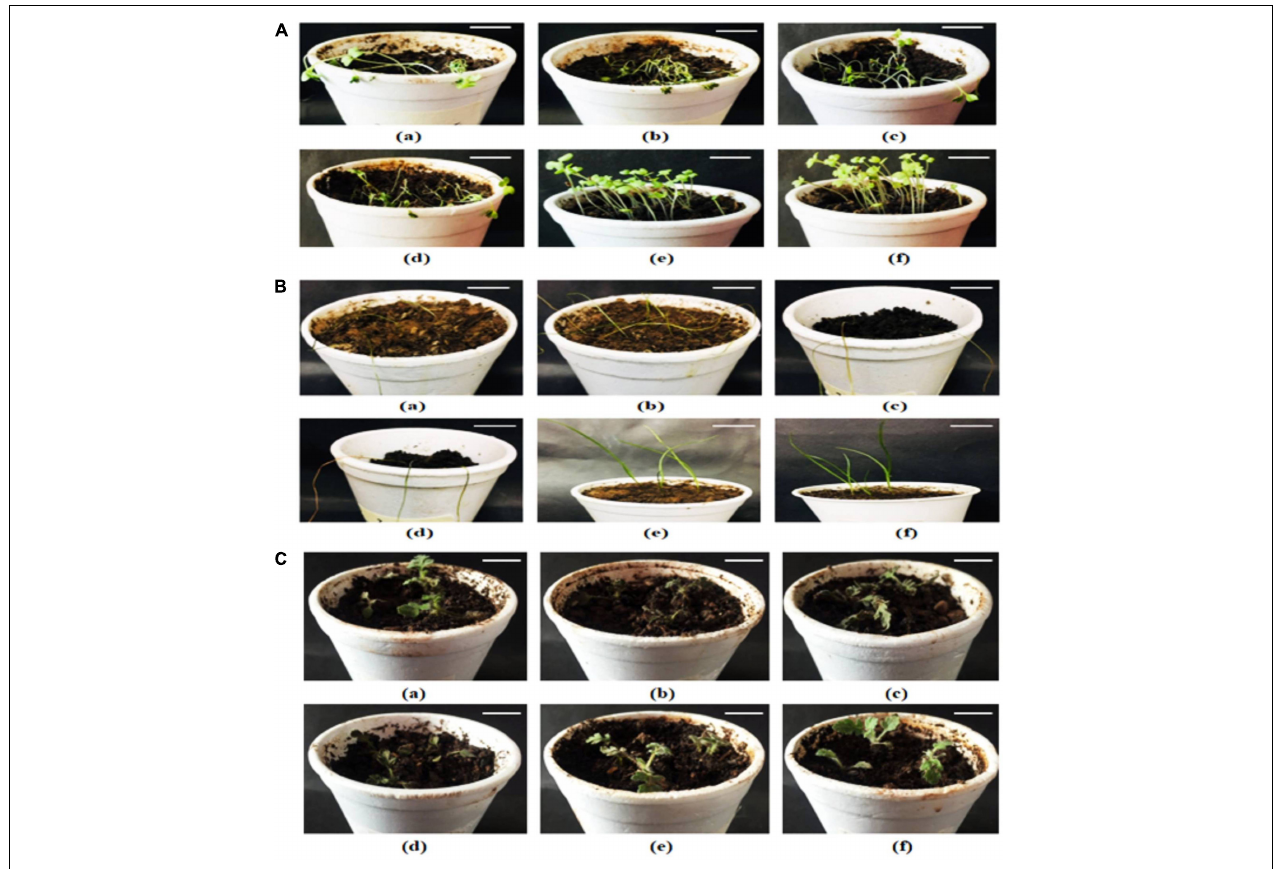
FIGURE 3 | Effect of 20% extracts on weed growth (A) Sinapis arvensis , (B) Lolium multiflorum , and (C) Parthenium hysterophorus . In each panel, (a–f) indicate effect of extracts of castor, artemisia, sorghum, wheat, 20% solvent control, and aqueous control, respectively, on each weed. S. arvensis showed the most significant growth suppression against all extracts and permanently wilted after 2 h of treatment application. P. hysterophorus demonstrated the least sensitivity against treatments (bar = 7.5 cm).